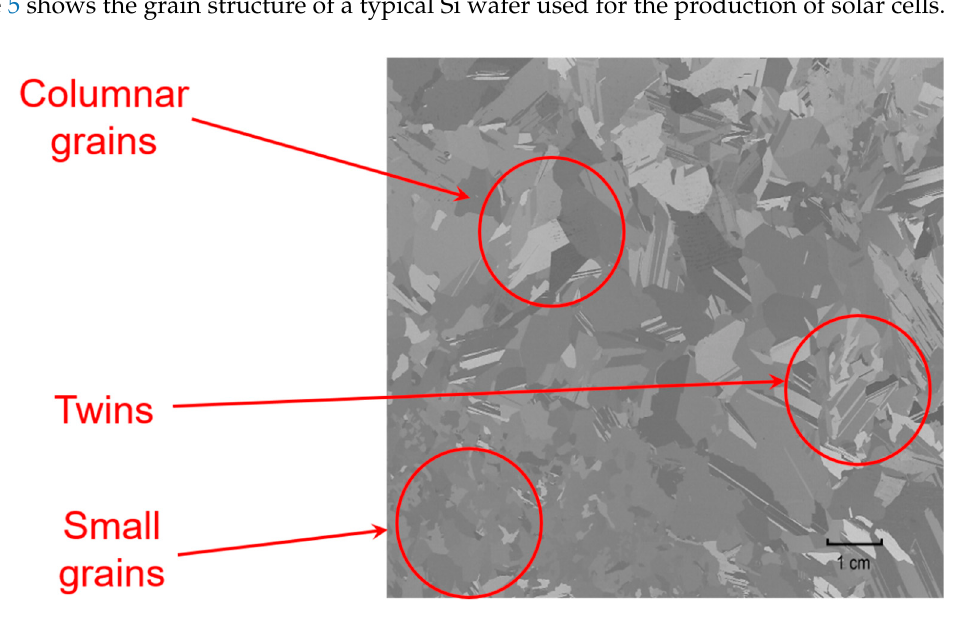
Figure 4. Diagram modified in order to take into account the chemical segregation of tellurium. Its increase with length changes the interface stability criterion, following the arrow.